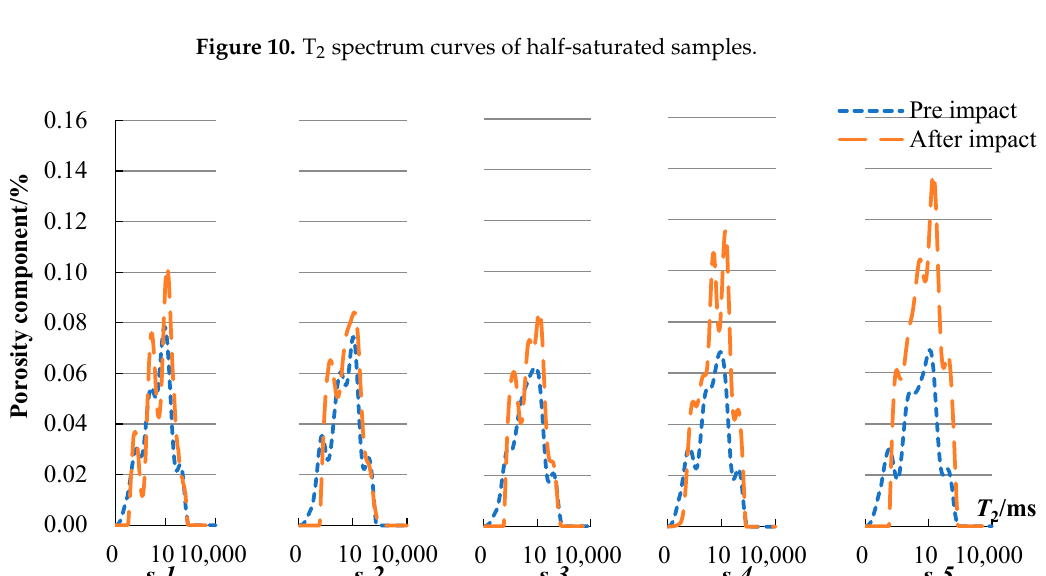
Figure 11. T 2 spectrum curves of saturated samples.